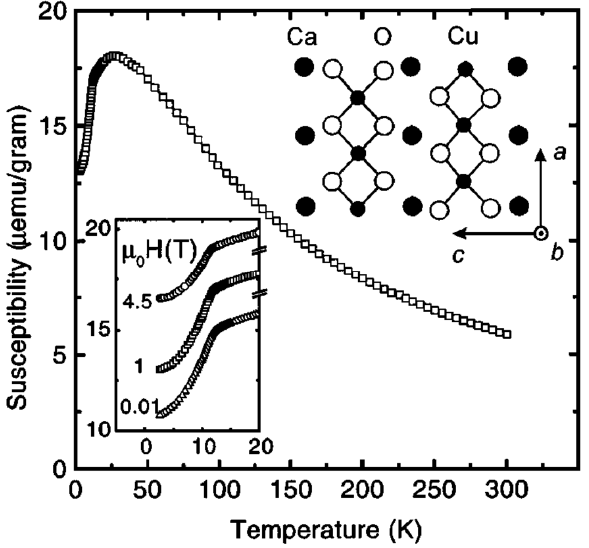
Figure 8. Susceptibility χ (T) of as-prepared polycrystalline Ca0.83CuO2 at µ0H = 1 T. The χ (T) curves at µ0H = 10 mT and 4.5 T are offset for clarity. The value of χ (T > 15 K) is independent from the applied field. Part of the unit cell of Ca0.83CuO2 is displayed. Reproduced with permission from [84], Figure 1.